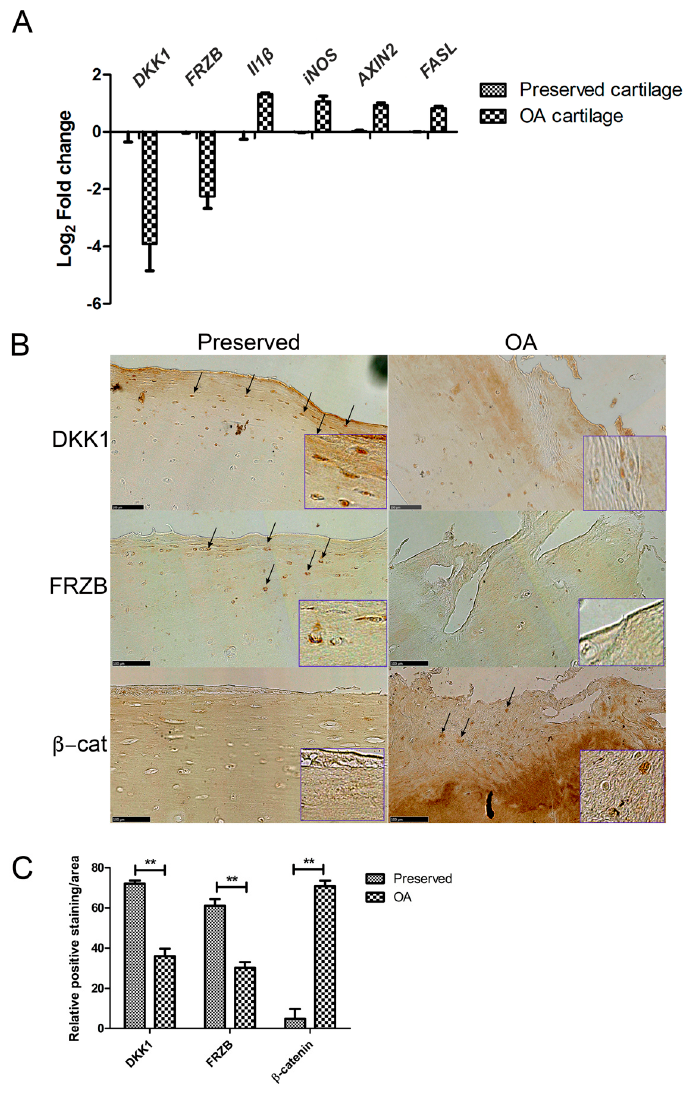
Figure 1. Gene and protein expression in preserved and Osteoarthritis (OA) cartilage. ( A ) RT-qPCR was performed to assess gene expression; ( B ) Immunohistochemistry (IHC) was used to visualize protein expression (arrows indicate positively stained areas). Representative pictures from one donor are shown. Images were taken using the Nanozoomer (scale bar 100 µ m), magnified pictures were indicated in inserts; ( C ) Quantification of positive staining was performed by ImageJ software. * p < 0.05, ** p < 0.01: significant correlation.